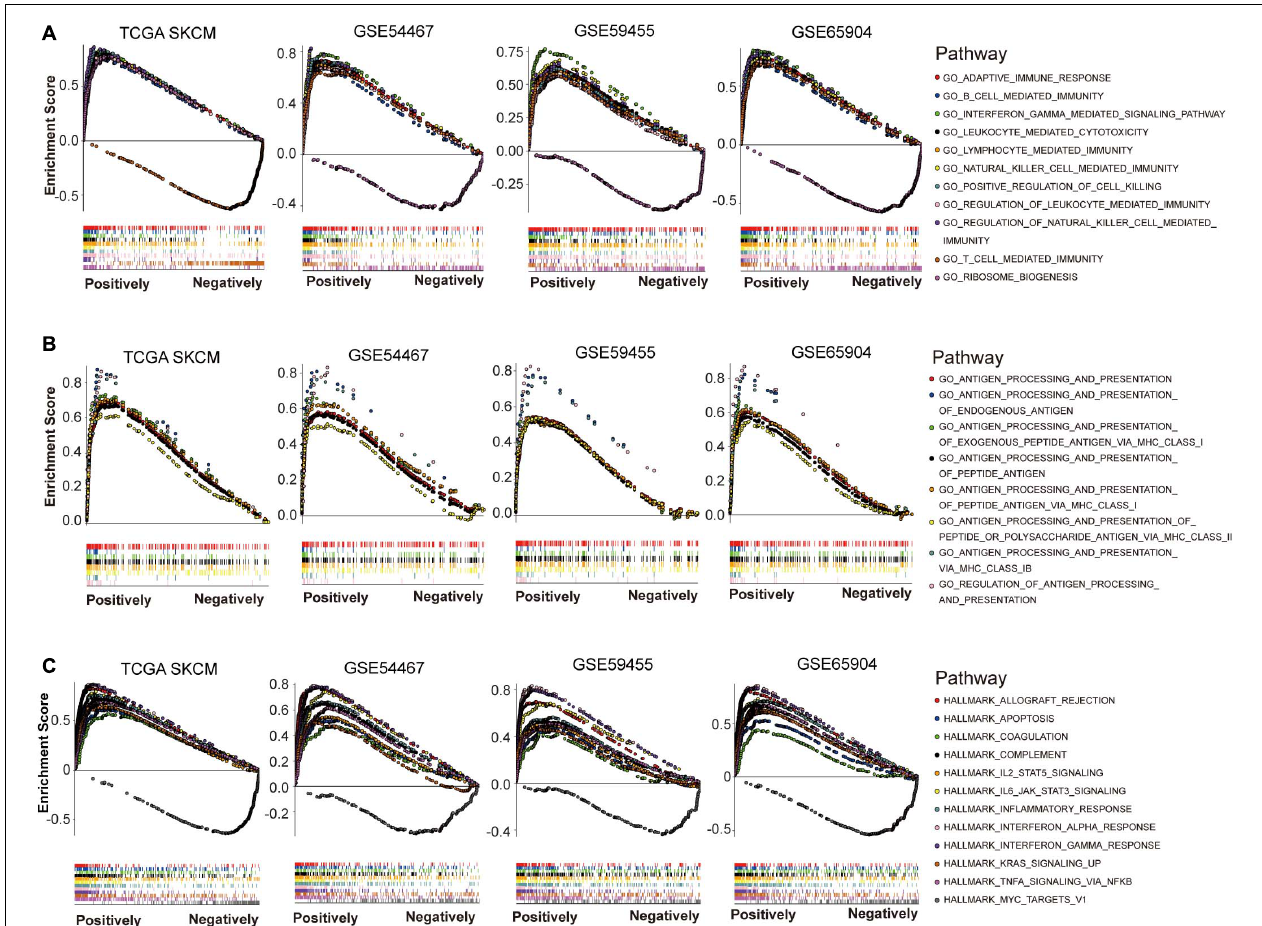
FIGURE 6 | Gene set enrichment analysis (GSEA) of NLRC5 related gene signature in melanoma datasets. (A) NLRC5 expression correlated positively with immune-related biological processes (BPs) in TCGA SKCM, GSE54467, GSE59455, and GSE65904 datasets. (B) NLRC5 expression correlated positively with biological processes (BPs) implicated in “ANTIGEN PROCESSING AND PRESENTATION” in TCGA SKCM, GSE54467, GSE59455, and GSE65904 datasets. (C) The HALLMARK correlating positively/negatively with NLRC5 expression in TCGA SKCM, GSE54467, GSE59455, and GSE65904